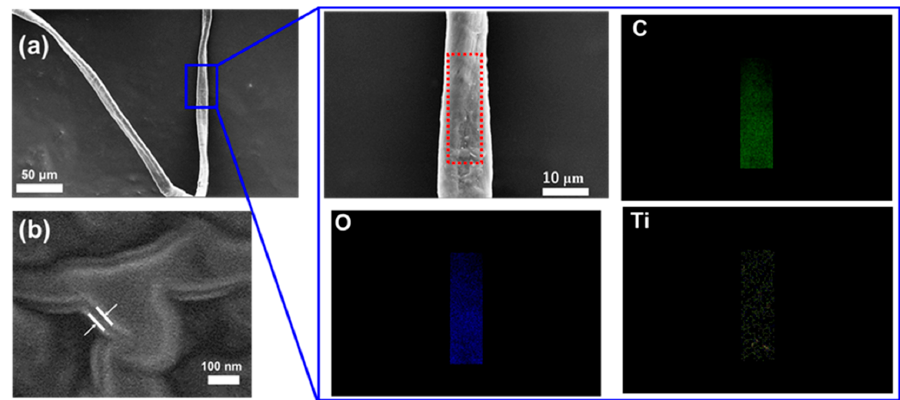
Figure 2. FE-SEM micrographs of ( a ) morphology of a single TiO 2 -coated cellulose nanofiber with a locally enlarged image and EDX element mapping and ( b ) a cross-section observation of the TiO 2 -coated cellulose nanofiber.